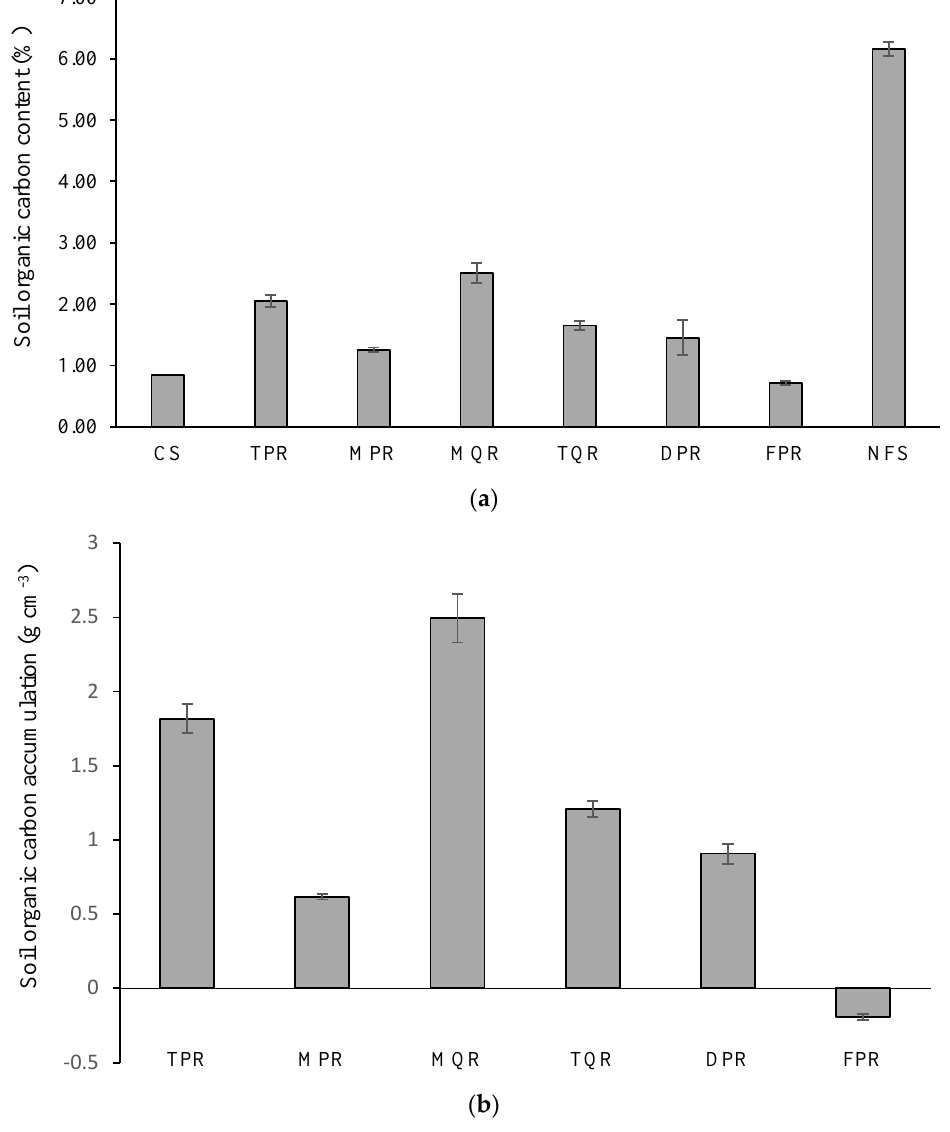
Figure 5. Soil organic carbon ( a ) content in each group and ( b ) its accumulation after one year. CS, control soil; MPR, middle portion of Pinus tabuliformis roots; TPR, tips of P. tabuliformis roots; MQR, middle portion of Quercus variabilis roots; tips of Q. variabilis roots; FPR, post-fire planted forest of P. tabuliformis ; DPR, dead P. tabuliformis roots; NFS, natural P. tabuliformis forest.